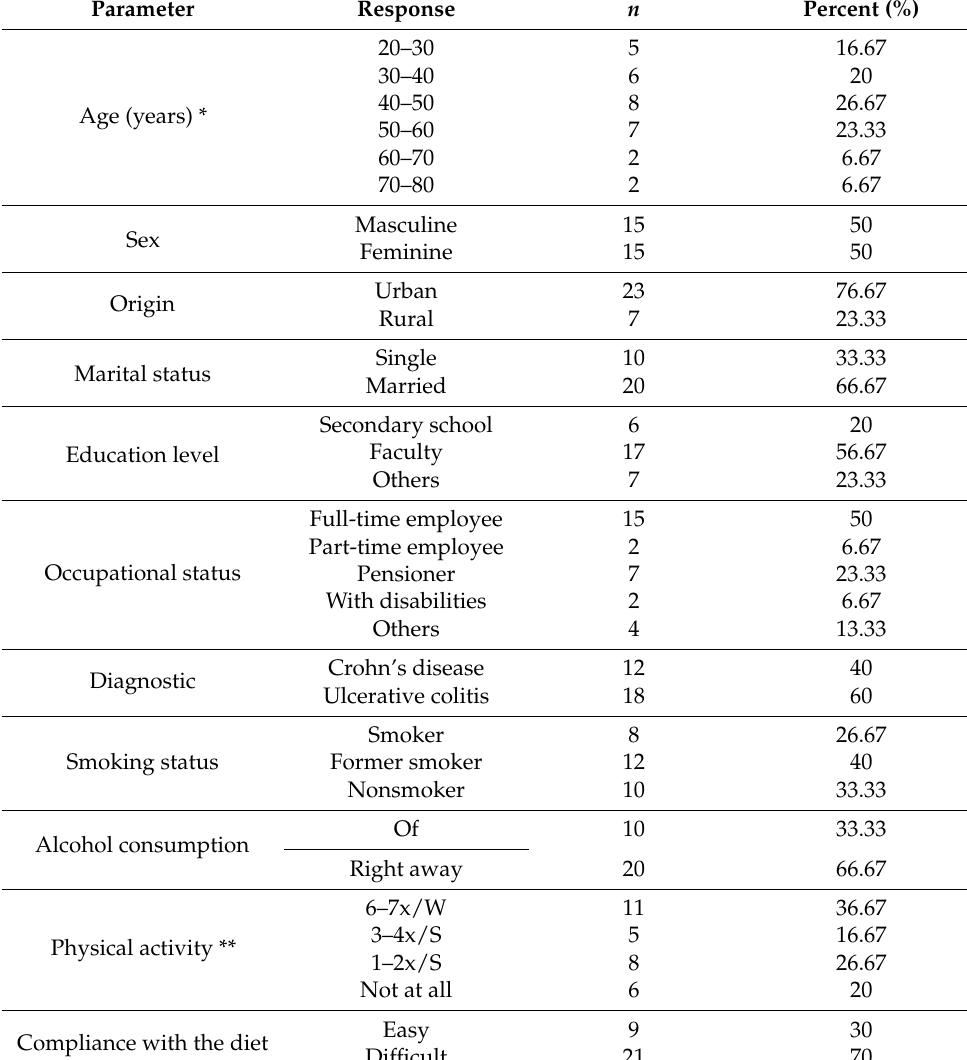
Table 1. Socioeconomic characterisation of the studied